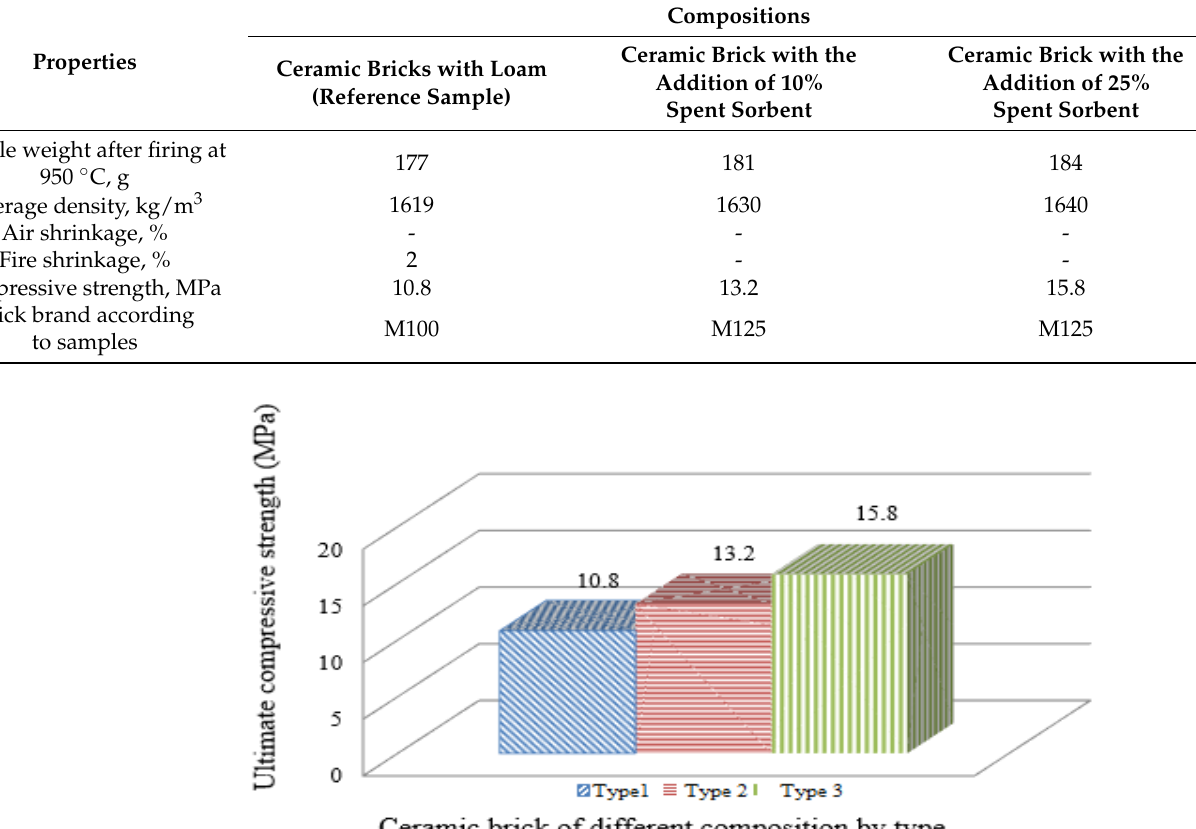
Figure 8. Histogram of fired ceramic samples.